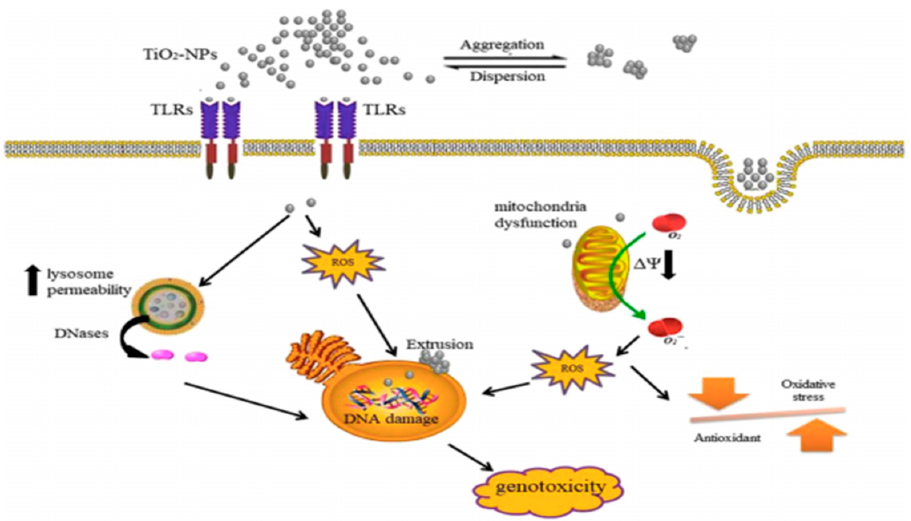
Figure 4. Mechanism of possible genotoxicity of TiO 2 NPs in cells. Adapted with permission from